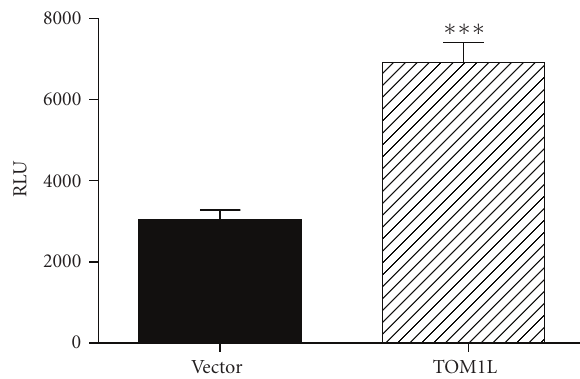
Figure 8: Jurkat cells were transfected with a firefly luciferase reporter for STAT3 (Signal-transducer-andactivator-of-transcrip- tion-3) together with plasmids encoding TOM1L or the empty plasmid construct. Included in each transfection was a reporter construct that expresses Renilla luciferase under the control of the β -actin promoter. 48 hours after the transfection, the cells were washed and lysed followed by reading in a luminometer. The activity of Renilla luciferase in each sample was used to normalize the luciferase